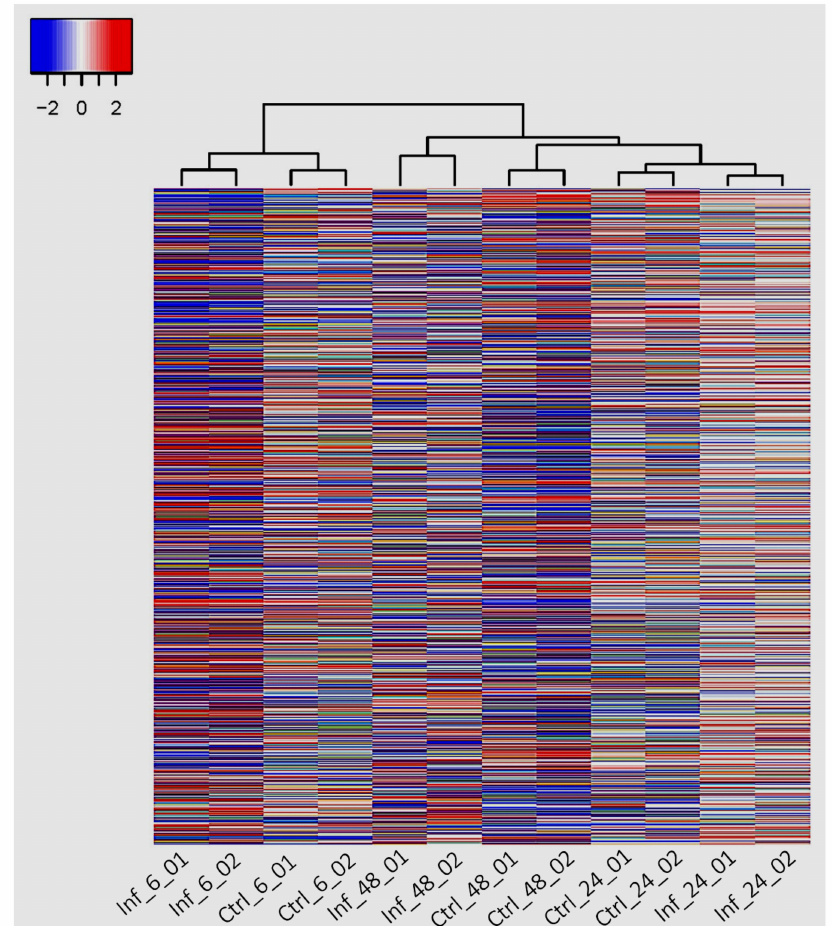
Figure 7. Heatmap showing hierarchical clustering of 533 DEGs at 6-, 24-, and 48-hpi. Only genes with log 2 FC of < 1 or > 1 and FDR < 0.05 were included in the heatmap. The color scale from blue (low) to red (high) corresponds to the gene expression values. Columns represent the samples (infected and control) and time points, while rows represent individual genes. The phylogenetic tree above the heatmap shows the hierarchical clustering of the